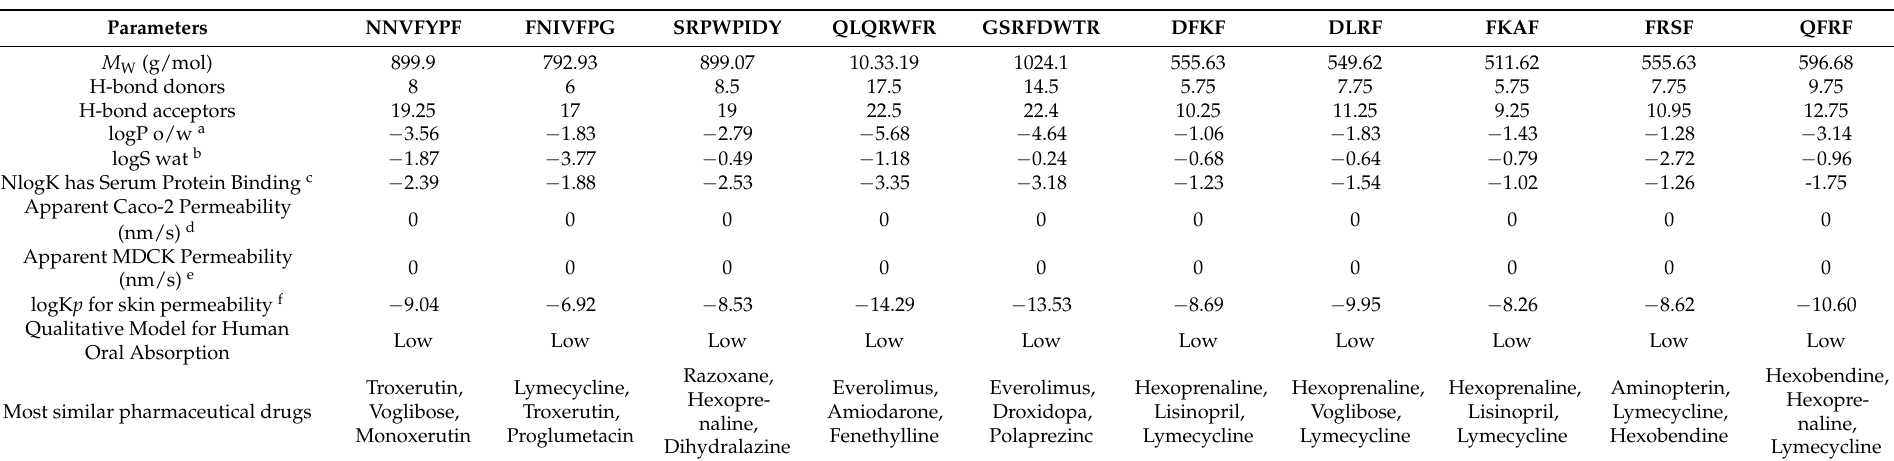
Table 3. Calculated drug-likeness parameter for subset of 10 selected peptide